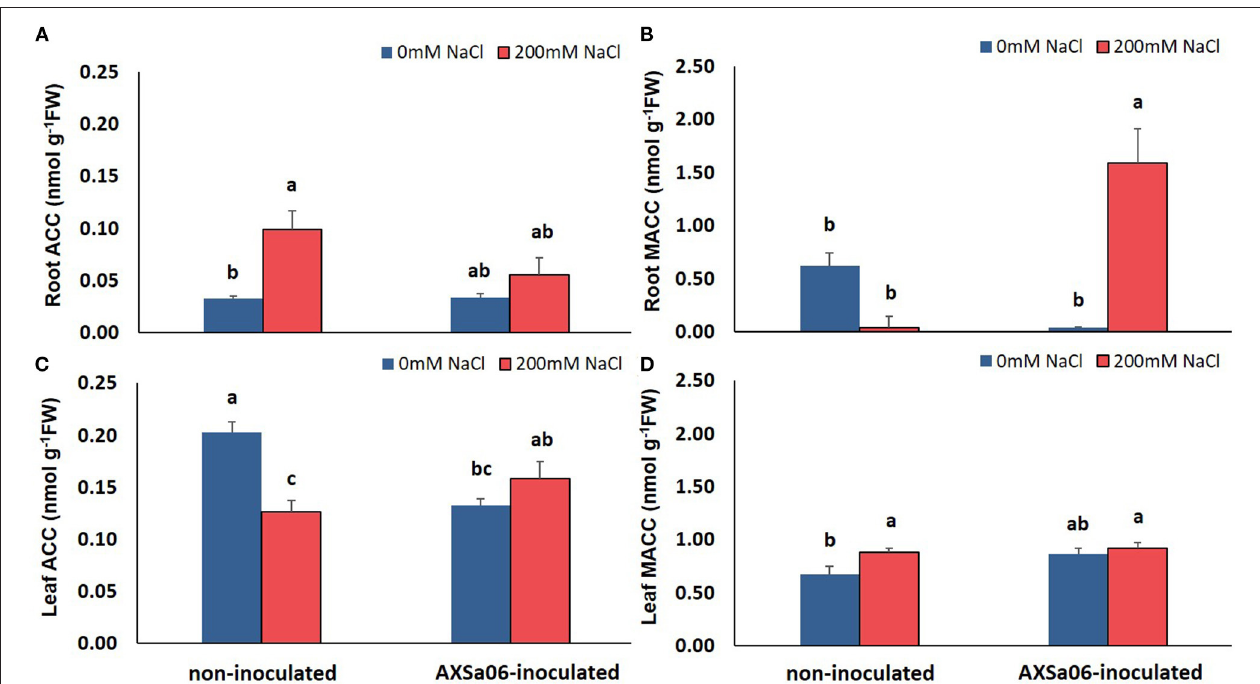
FIGURE 3 | Contents of ACC and MACC in roots (A,B) and leaves (C,D) of tomato seedlings inoculated or not with AXSa06 ( Pseudomonas oryzihabitans ) at exposure to 200mM NaCl for 7 days. Data are means of five biological replicates ± standard error. Different letters indicate statistically significant differences between treatments based on Duncan’s multiple range test ( P <